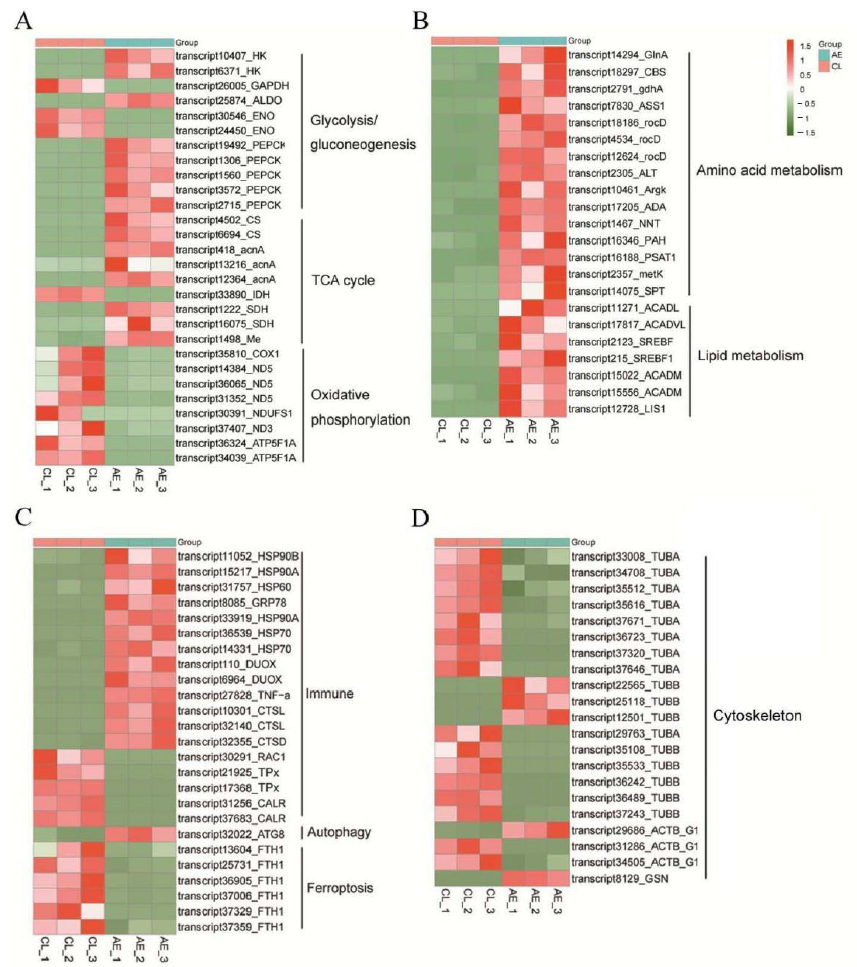
Figure 5. Heatmaps showed DEGs related to metabolism, immune, autophagy, ferroptosis, and cytoskeleton. ( A ) DEGs were related to glycolysis/gluconeogenesis, the TCA cycle, and oxidative phosphorylation. ( B ) DEGs were related to amino acid and lipid metabolism. ( C ) DEGs were re- lated to immune, autophagy, and ferroptosis. ( D ) DEGs were related to the cytoskeleton. The color scale represents FPKM after standard normalization. HK : hexokinase; Aldo : fructose-bisphosphate aldolase; GAPDH : glyceraldehyde-3-phosphate dehydrogenase; Eno : enolase; PEPCK : phosphoe- nolpyruvate carboxykinase; CS : citrate synthase; AcnA : aconitate hydratase; IDH : Isocitrate dehy-